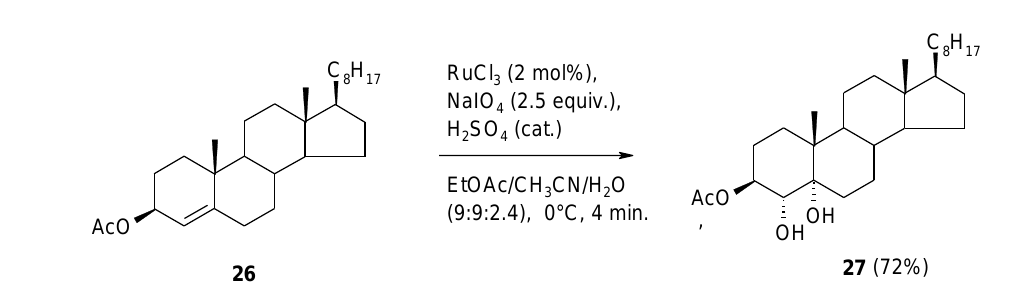
Scheme 18. Dihydroxylation of cholest-4-en-3β-yl acetate